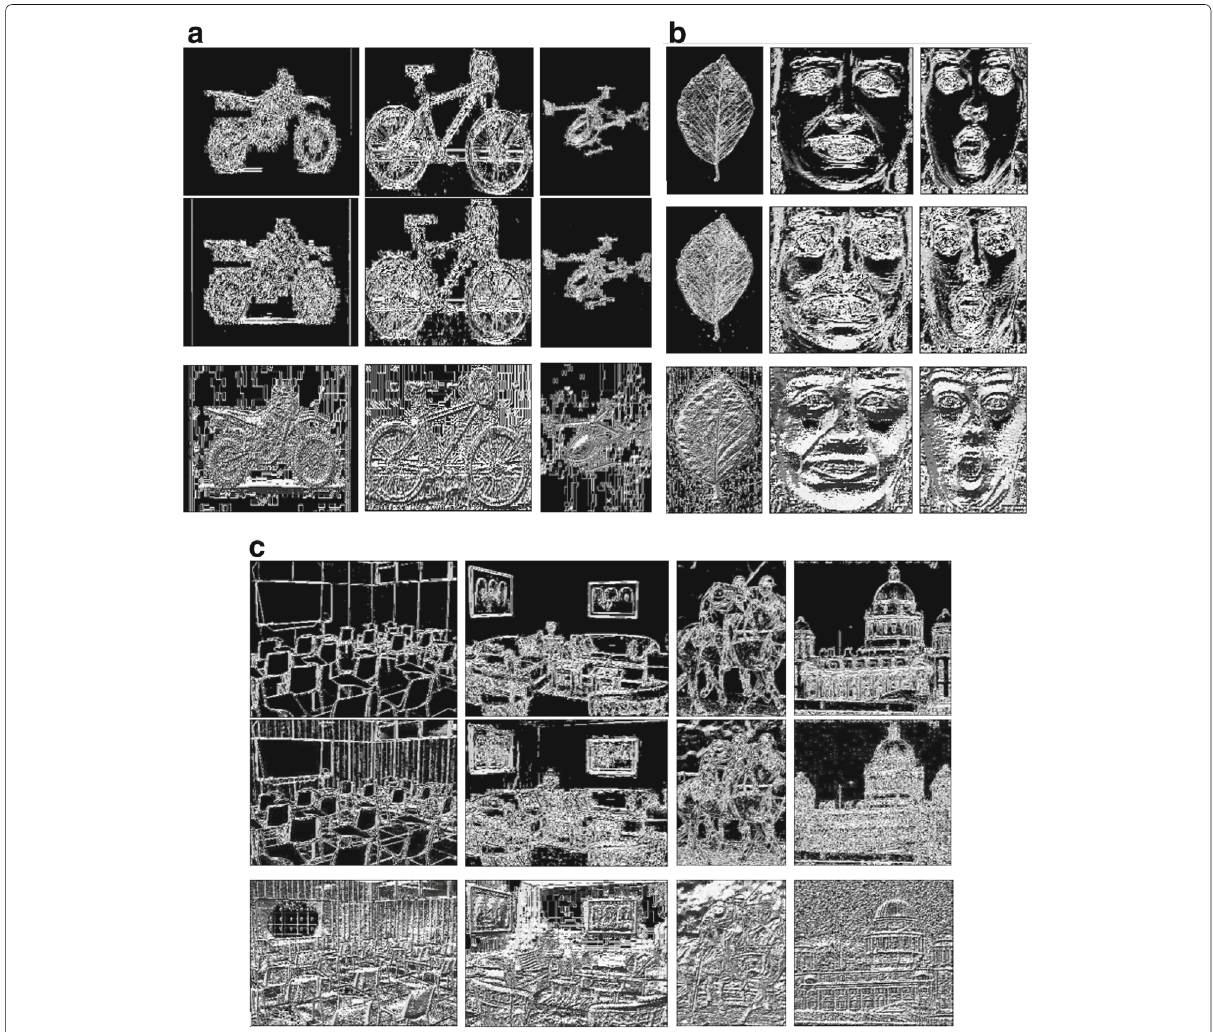
Fig. 8 Coded image by DTCTH, LTP, and CENTRIST for corresponding images in Fig. 4. a Object classes. b Leaf and expression classes. c Scene classes ( firstrow —DTCTH-coded image, secondrow —LTP-coded image, and thirdrow —CENTRIST-coded